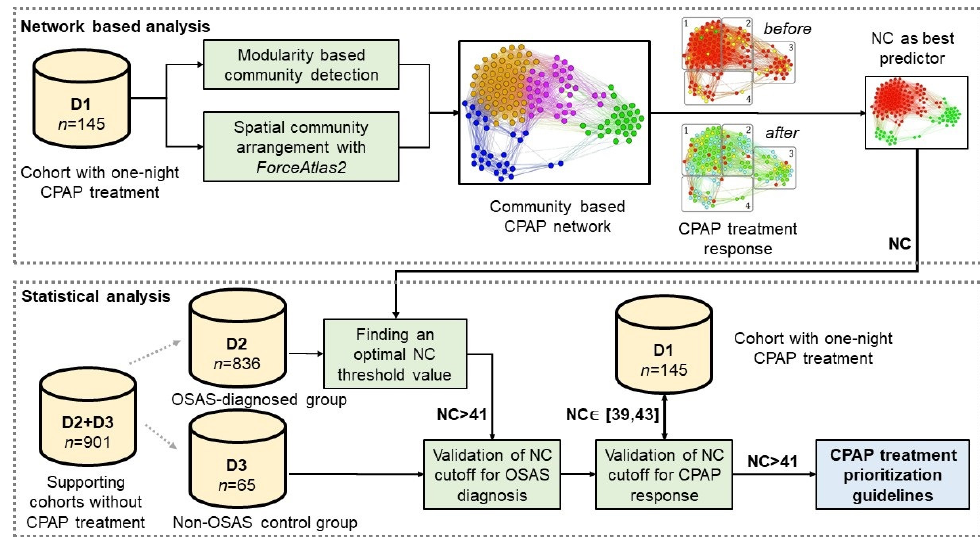
Figure 1. Overview of datasets and study design. The network-based analysis stage used cohort D 1 to model a CPAP patient network. By corroborating the community structure of this network with the CPAP treatment response of each patient (i.e., measured as AHI improvement), we extracted neck circumference (NC) as the most significant indicator of AHI improvement. We further used this information in the statistical analysis stage, in which used a larger D 2 + D 3 supporting cohort to find an optimal NC threshold value for OSA-diagnosed patients. Cohort D 3 was the non-OSA control group. The study resulted in the definition of a rule of thumb guideline for CPAP treatment prioritization of patients with OSA